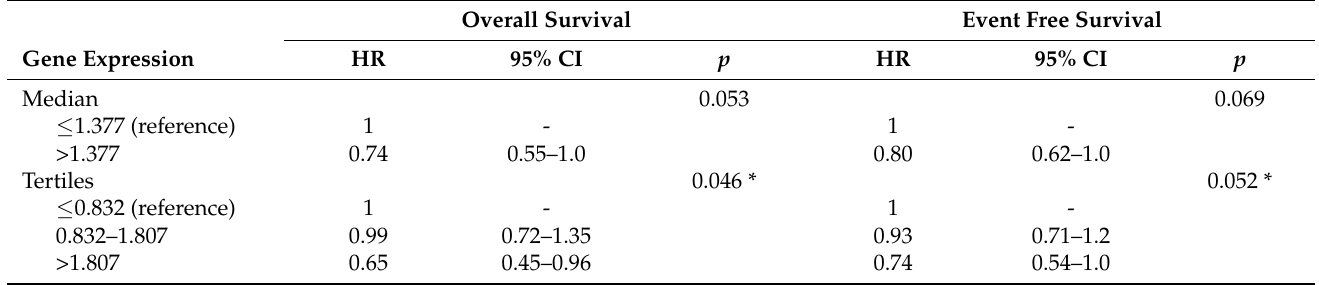
Figure 6. Association between KLRB1 gene expression and the main patient characteristics at di- agnosis evaluated on the entire cohort. ( A ) Age; ( B ) MYCN status; ( C ) INSS stage (International Neuroblastoma Staging System). Table 3. Survival of the whole cohort of patients with NB in relation to KLRB1 gene-expression values, evaluated by the multivariable Cox regression